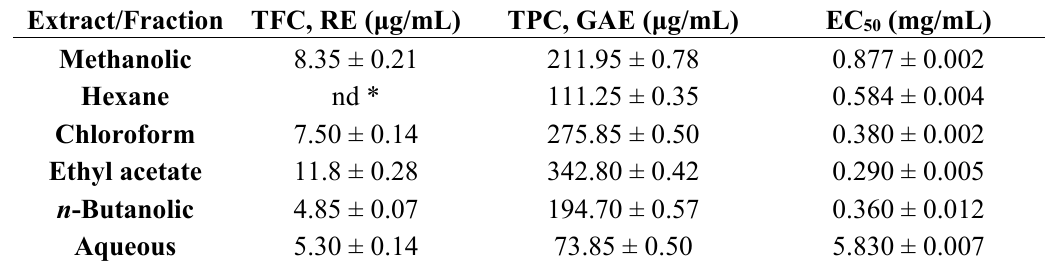
Table 1. Total flavonoid content (TFC) and total phenolic content (TPC) of methanolic extract of Carissa opaca roots and its fractions in various solvents, and their EC 50 values in DPPH assay ( n = 3)